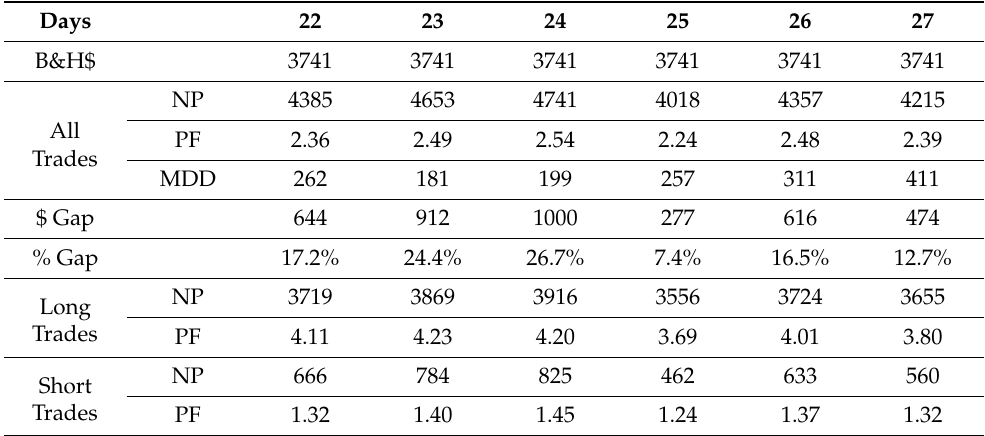
Table 2. Results for Ethereum trades.